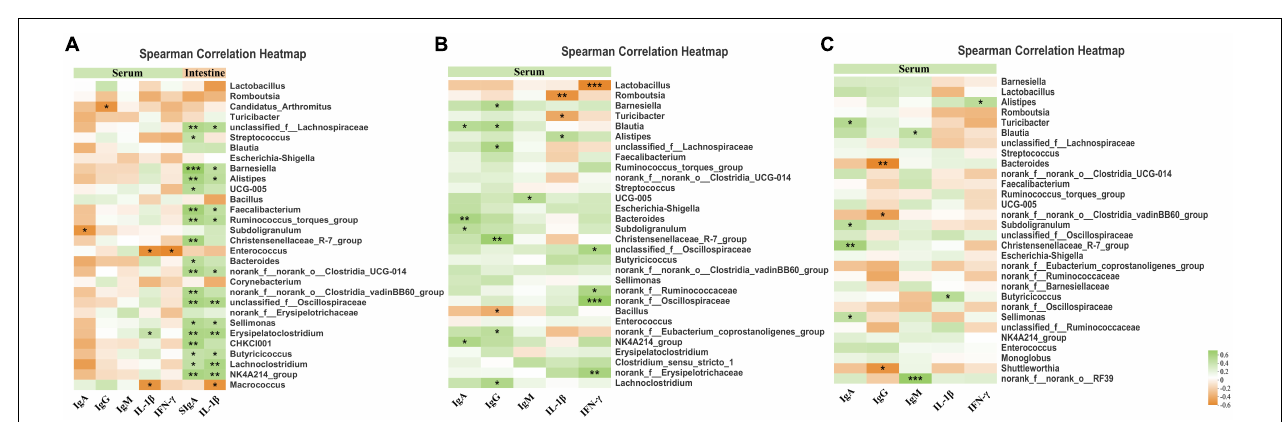
FIGURE 7 | The Spearman correlation among intestinal microbiota, anti-inflammatory, and immune parameters. (A) Heatmap of Spearman’ s correlation between ileal microbiota, anti-inflammatory, and immune parameters. (B) Heatmap of Spearman’ s correlation between cecal microbiota, anti-inflammatory and immune parameters. (C) Heatmap of Spearman’s correlation between Colonic microbiota, anti-inflammatory, and immune parameters. The correlation was analyzed based on the relative abundance of 30 phylotypes at the genus level. Cells are colored based on the correlation coefficient between the significantly altered bacteria and anti-inflammatory or immune parameters. The green suggests a positive correlation, and the yellow suggests a negative correlation. The “*” indicates 0.01 < p ≤ 0.05, “**” indicates 0.001 < p ≤ 0.01, and “***” indicates p ≤ 0.001.